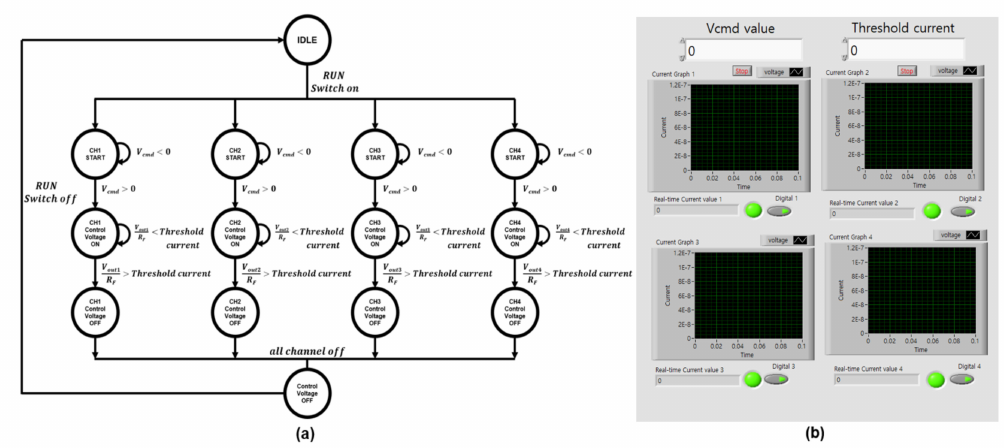
Figure 3. ( a ) A finite-state machine (FSM) algorithm adopted to monitor ionic leakage current ( I N ); ( b ) user interface window customized using the LABVIEW software Version NXG